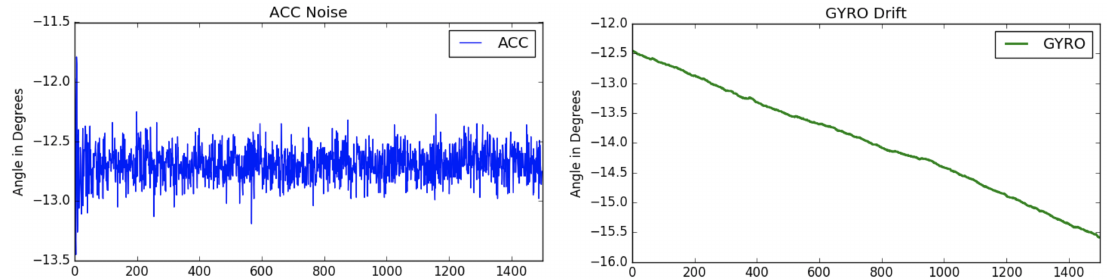
Figure 3. Accelerometer noise and gyroscope drift in static conditions ( y axis), plotted over time ( x axis, in equidistant sensor